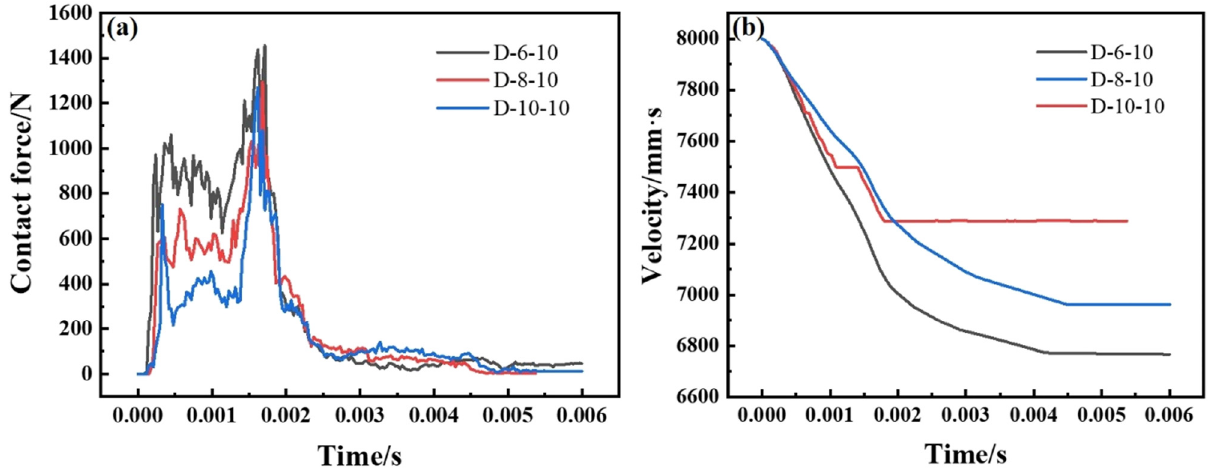
Figure 6: Comparison between contact force – time and velocity – time curves of D - 6 - 10, D - 8 - 10, and D - 10 - 10. ( a ) Contact force – time curves and ( b ) velocity – time